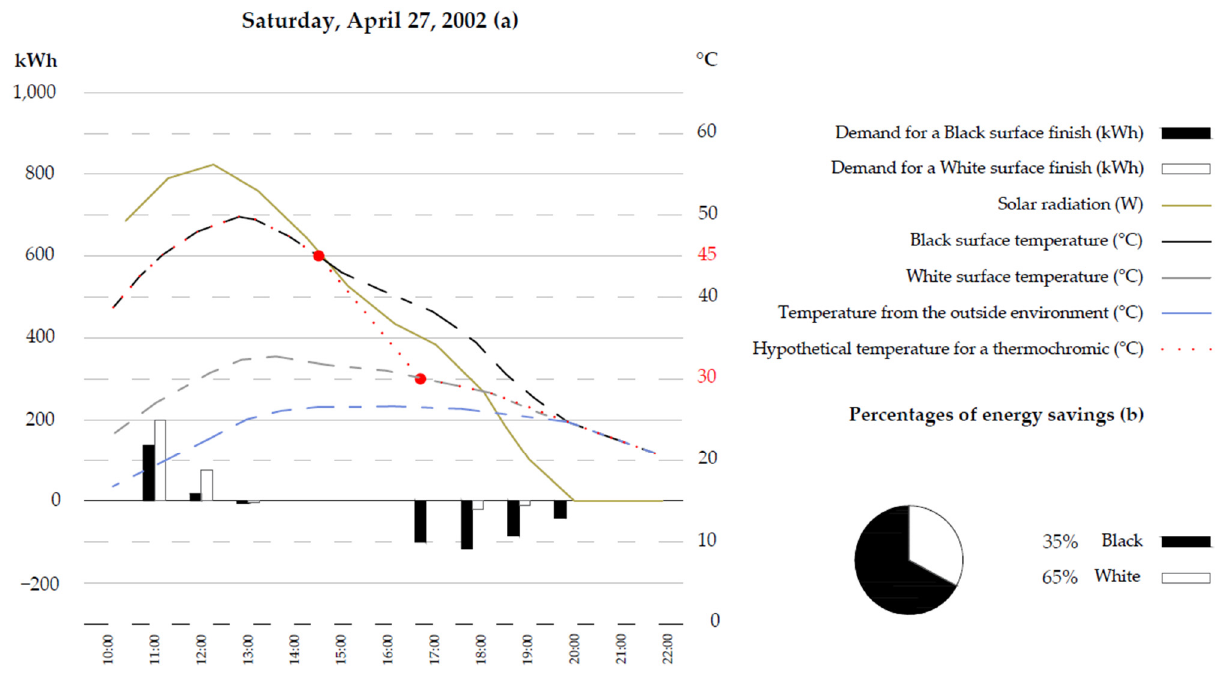
Figure 20. ( a ) Surface temperature and energy performance for 27 April 2002, in Madrid. ( b ) White vs. black surface finish energy savings.